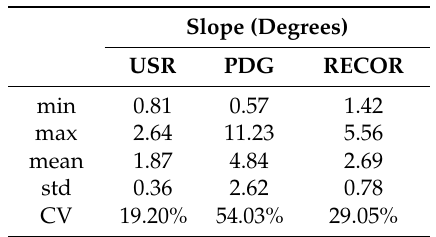
Table 2. Zonal statistics for slope (degrees) obtained for the 1 km MODIS pixel centered in each micrometeorological tower (USR, PDG and